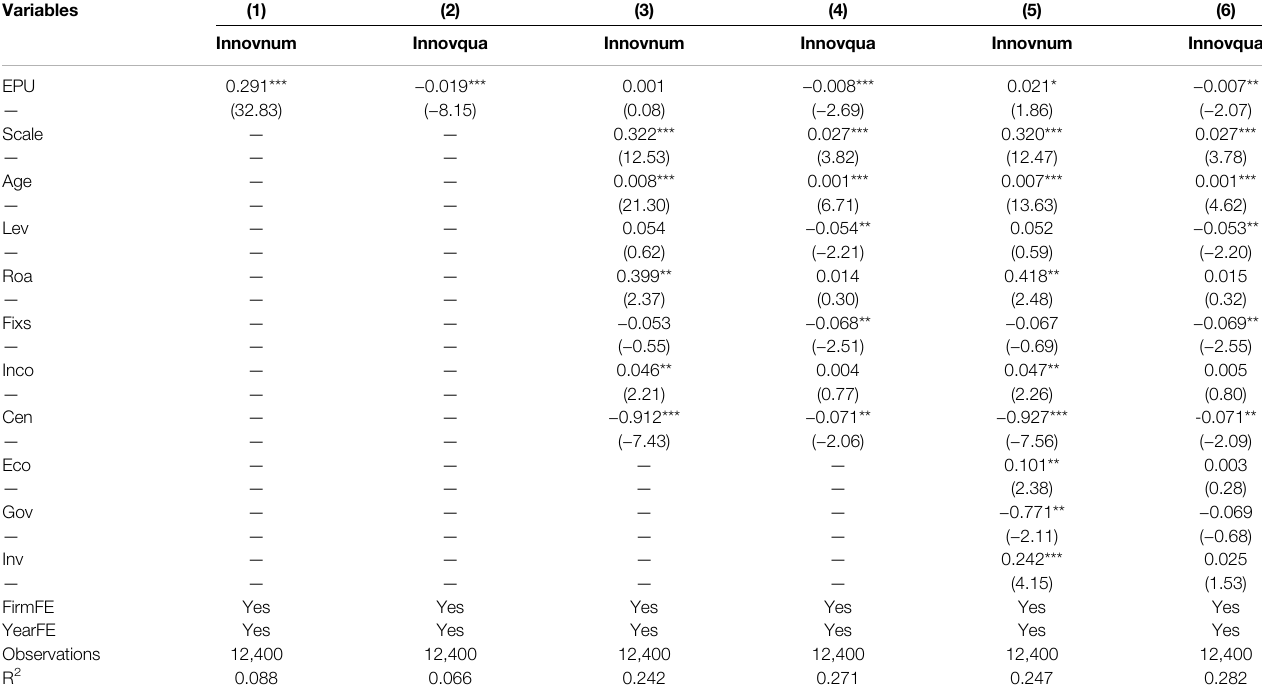
TABLE 2 | Regression results of EPU and fi rm innovation.